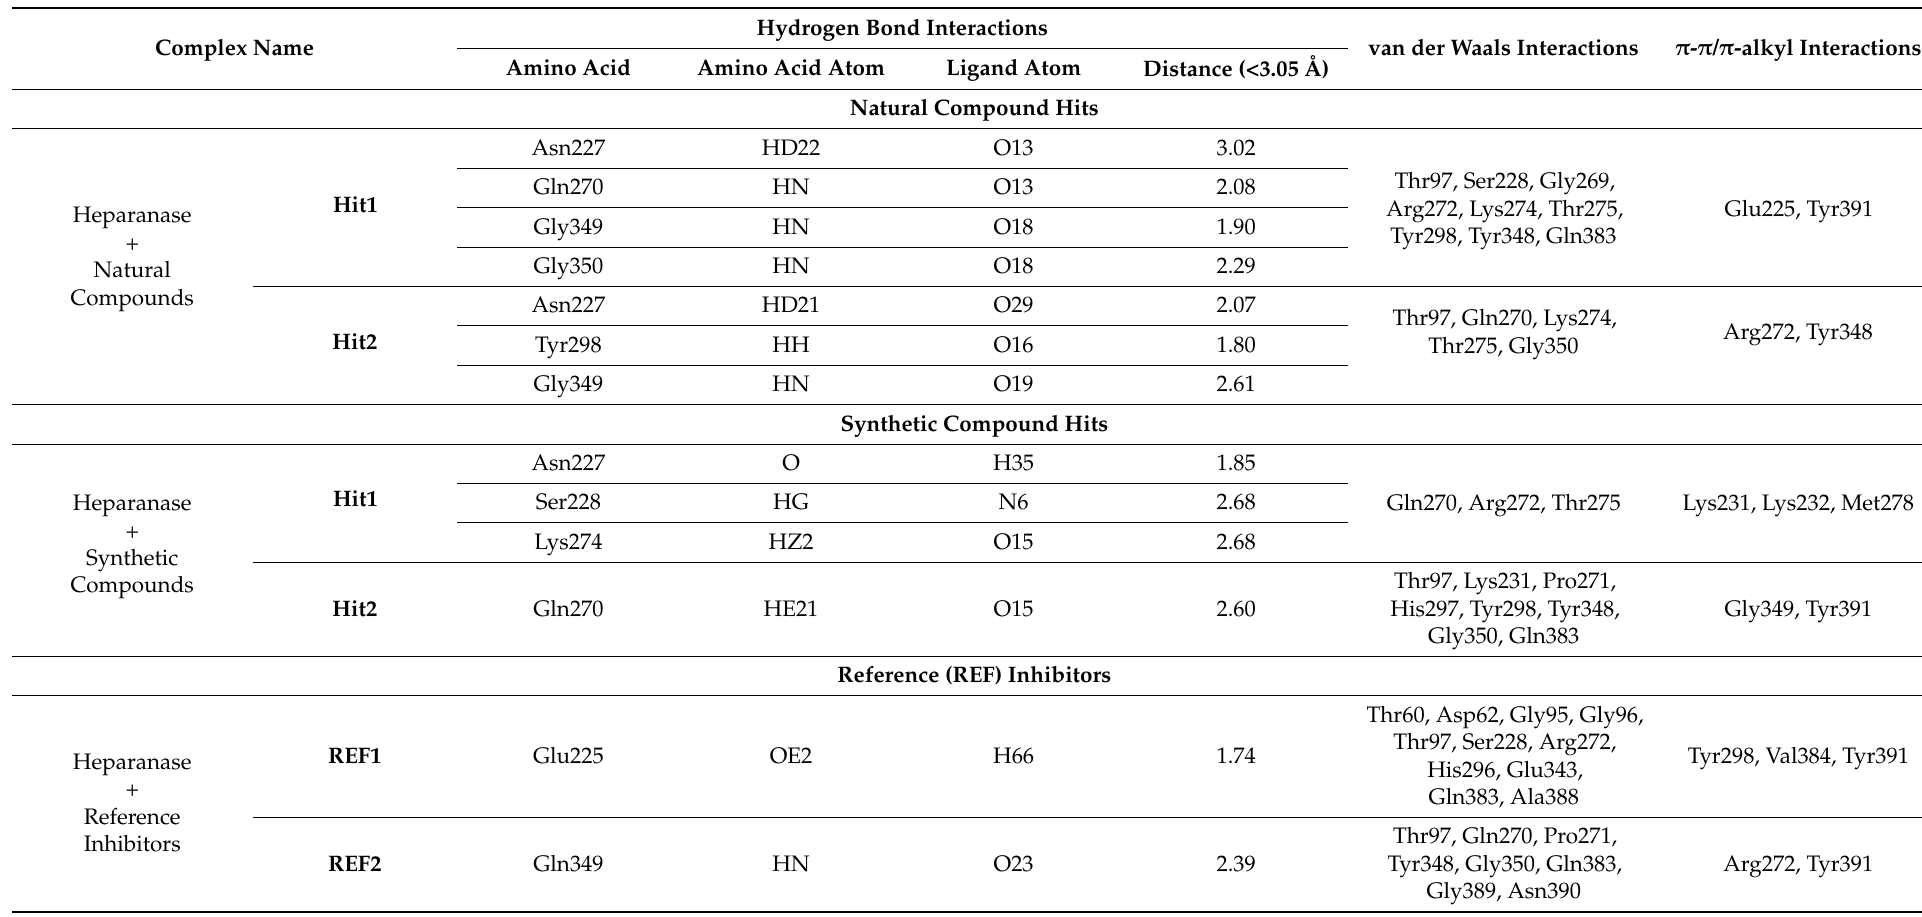
Table 4. Molecular interactions of the compounds (reference and hits) with Heparanase active site residues obtained from stable molecular dynamics simulation